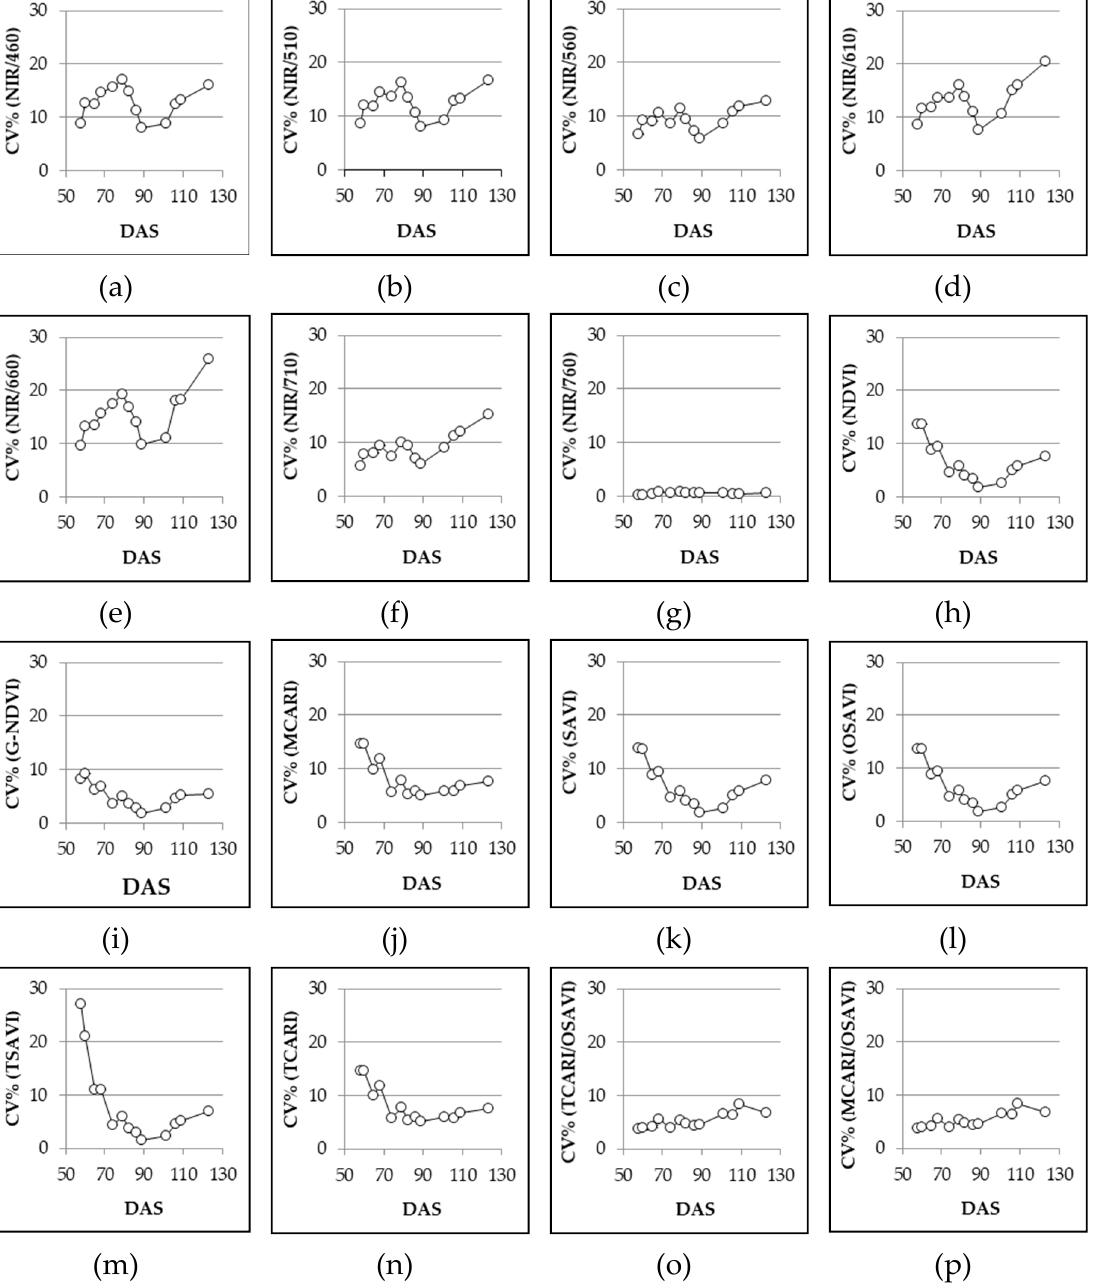
Figure 4. Experiment 5#. Coefficient of variation (CV%) of different VIs across different sampling dates, generated with bootstrap analysis by using SET DAY (see Section 2.3 data analysis). DAS = days after sowing.